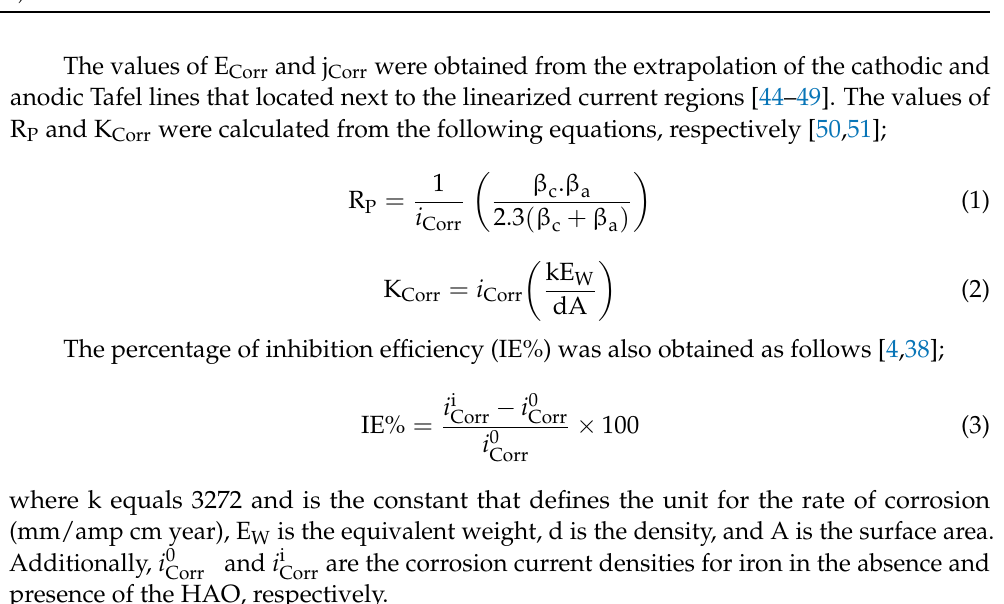
Figure 7. CPP curves for iron after 48 h immersion in (1) 3.5% NaCl solutions in the absence and